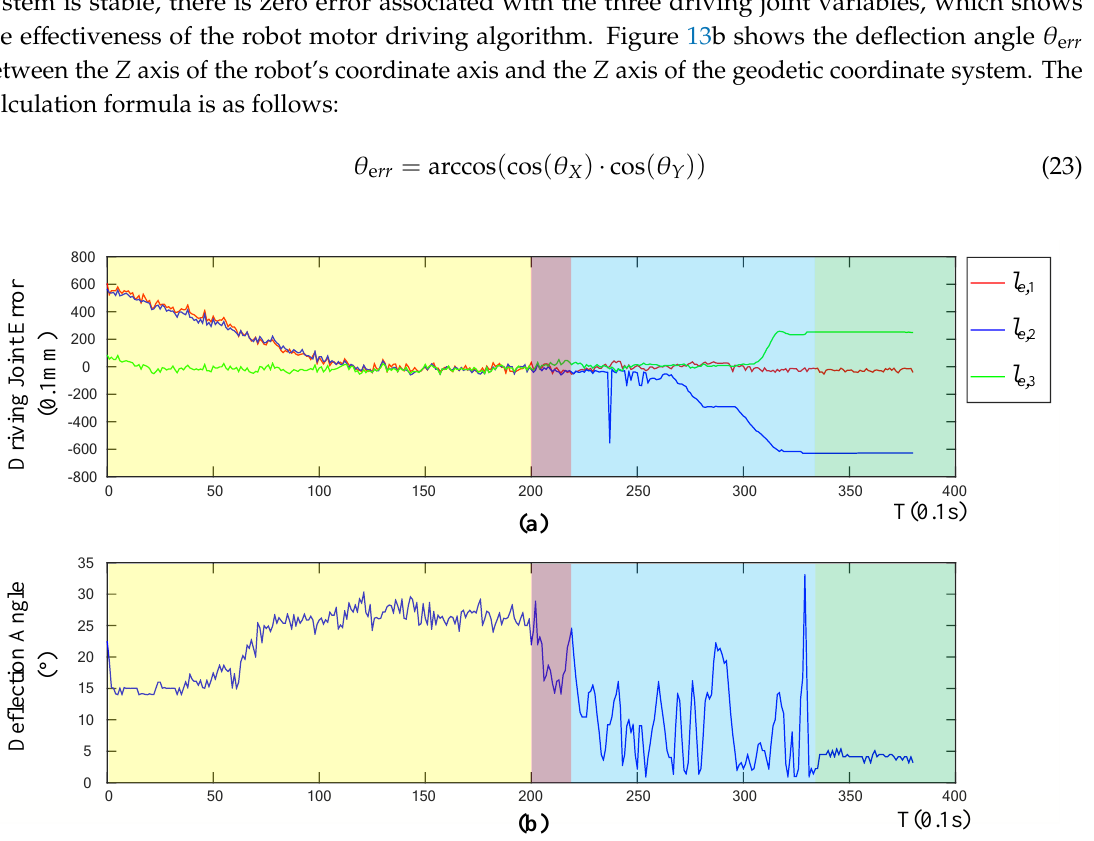
Figure 13. ( a ) Diagram of driving joint error, and ( b ) deflection angle.